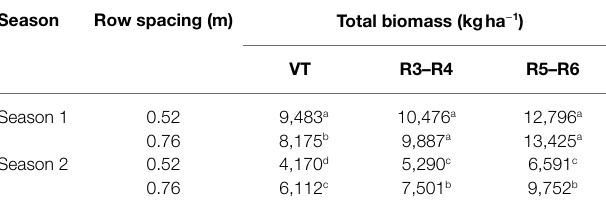
TABLE 4 | Effect of season and row spacing on total biomass at the tasseling (VT) stage, the linear development phase of kernel filling (R3–R4), and physiological maturity (R5–R6) across all plant